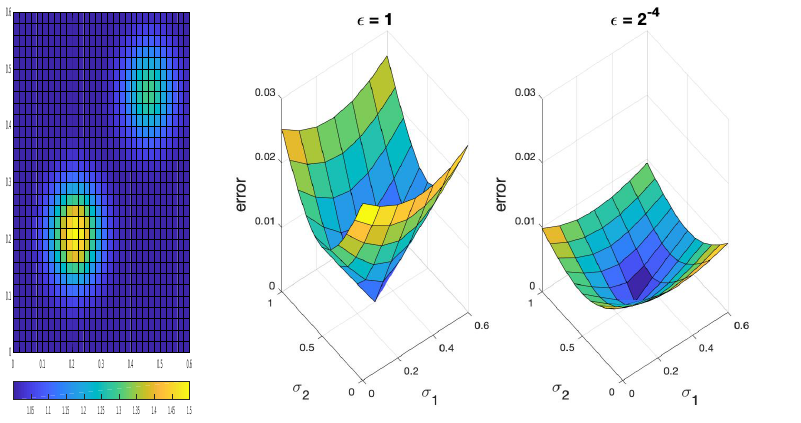
Figure 2. Test 2: The panel on the left shows the ground-truth medium with σ 1 = 0.5 and σ 2 = 0.3 in (59). The two plots on the right show, for different (cid:101) , the perturbation in the measured data versus the perturbation in σ 1,2 .